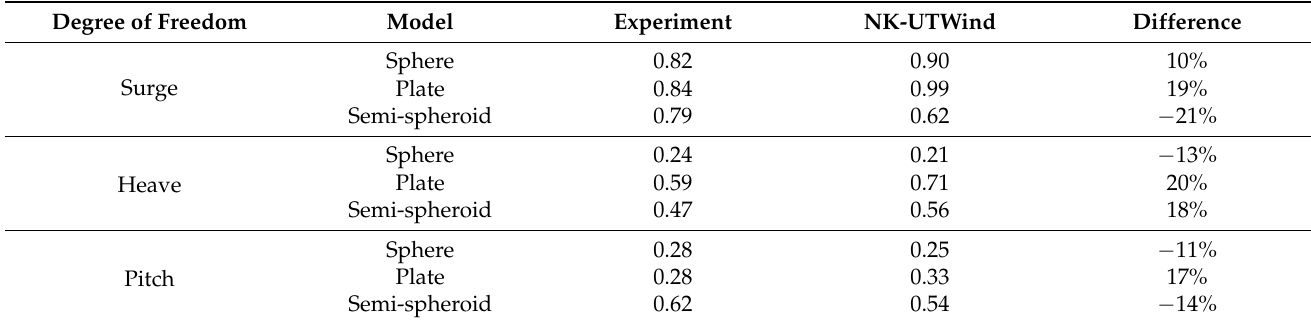
Table 5. Added mass coefficients, C a , obtained from free decay tests in still water.